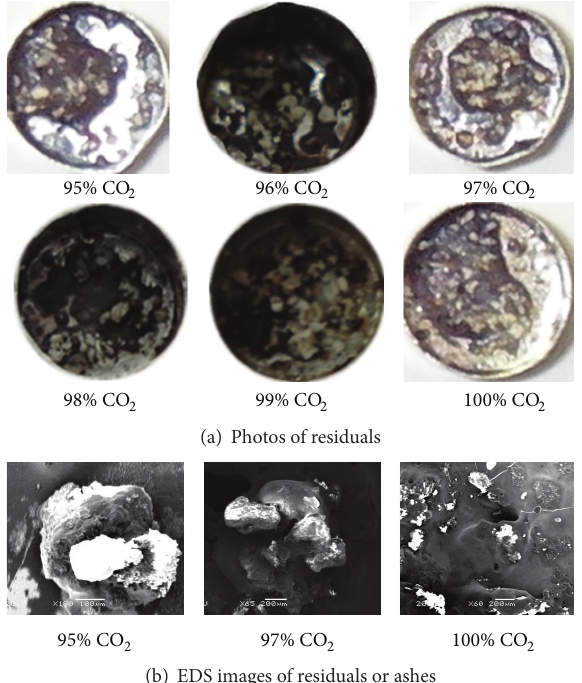
Figure 13: Photos of residuals at various CO 2 concentrations with a temperature of 1200 ∘